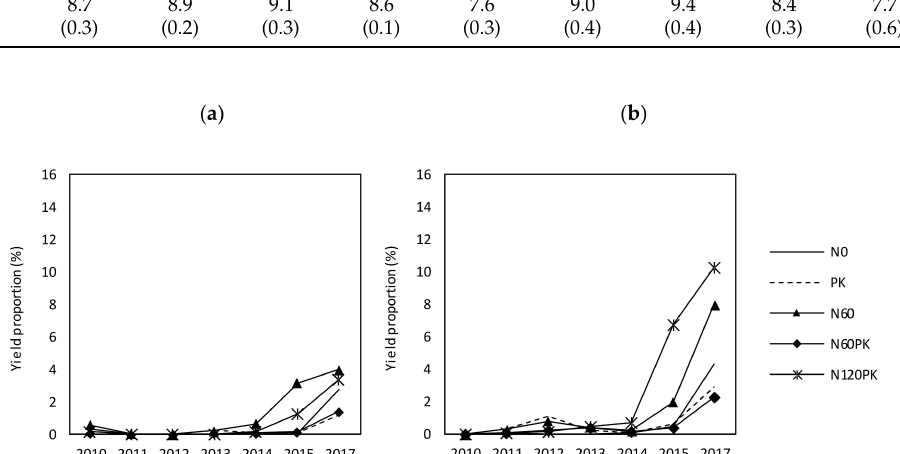
Figure A2. Percentage contribution of Cirsium arvense to the aboveground plant biomass in the first ( a ) and second ( b ) cuts with different fertilization treatments between 2010 and 2017 (except 2016). Two years after the extreme summer flood in 2013, the treatments N60 and N120PK most strongly